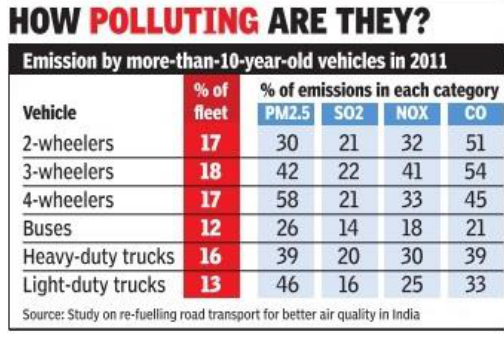
Fig. 6. NO x emissions by old vehicles